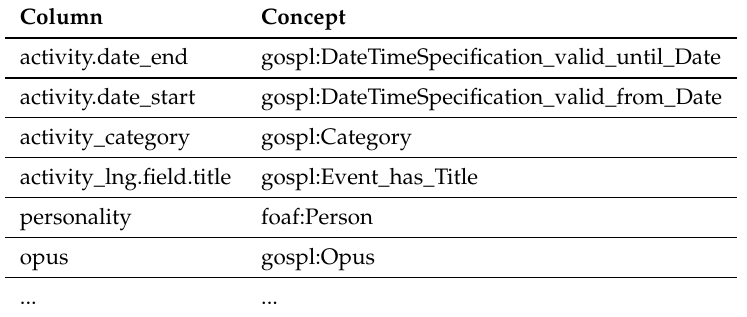
Table 1. Mapping of elements in the Bozar database to concepts in the cultural